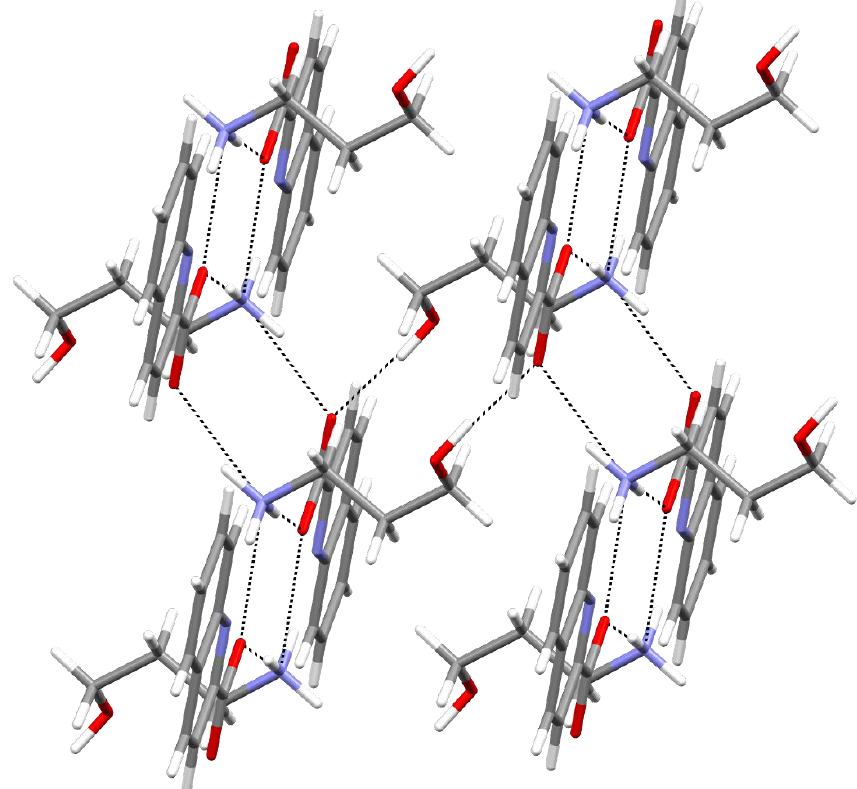
Figure 2. Perpendicular view to the section of a layer of hydrogen-bonded cations and anions in the structure of 1 .